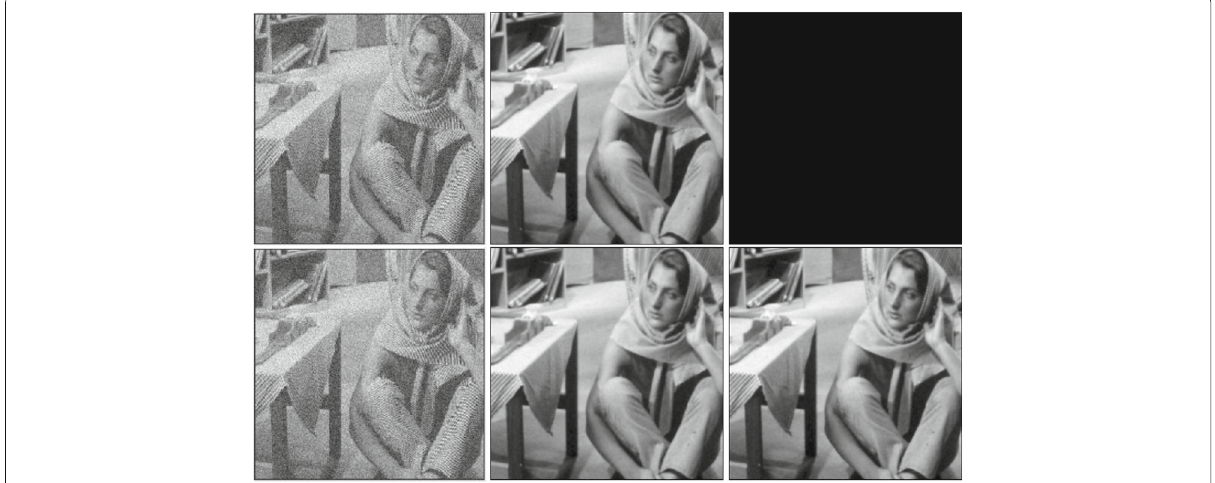
Fig. 9 Toprow , restored Barbara image by PMPL method; bottomrow , restored images by our algorithm; firstcolumn , noisy images; tworight columns , recovered with λ = 40.98 and λ = 40.97,